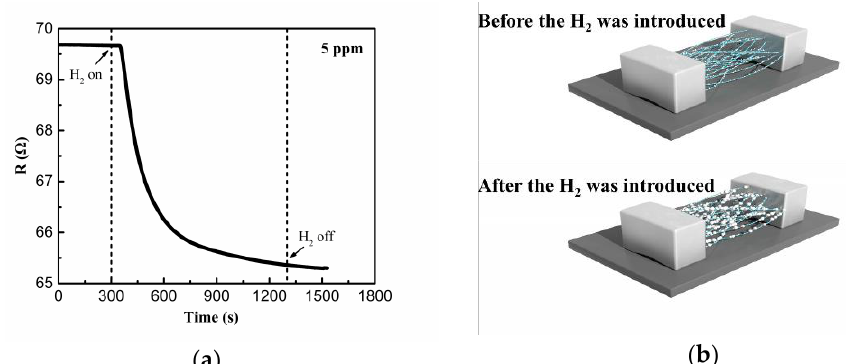
Figure 6. ( a ) Electrical resistance changes of the hydrogen sensor when exposed to 5 ppm H 2 . ( b ) The schematic of the hydrogen sensor before and after H 2 exposure.